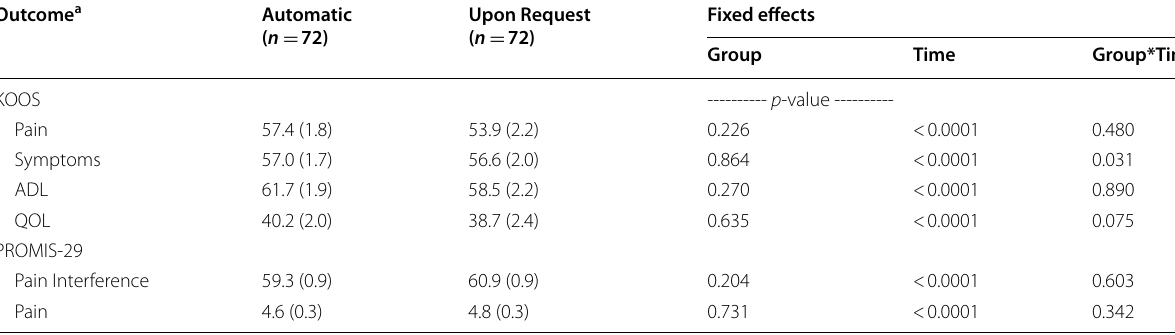
a All values are least squares means (standard error of the mean) adjusted for age and pre-operative score ADL Activities of daily living, KOOS Knee injury and Osteoarthritis Outcome Score, PROMIS Patient-Reported Outcomes Measurement Information System, QOL Quality of life